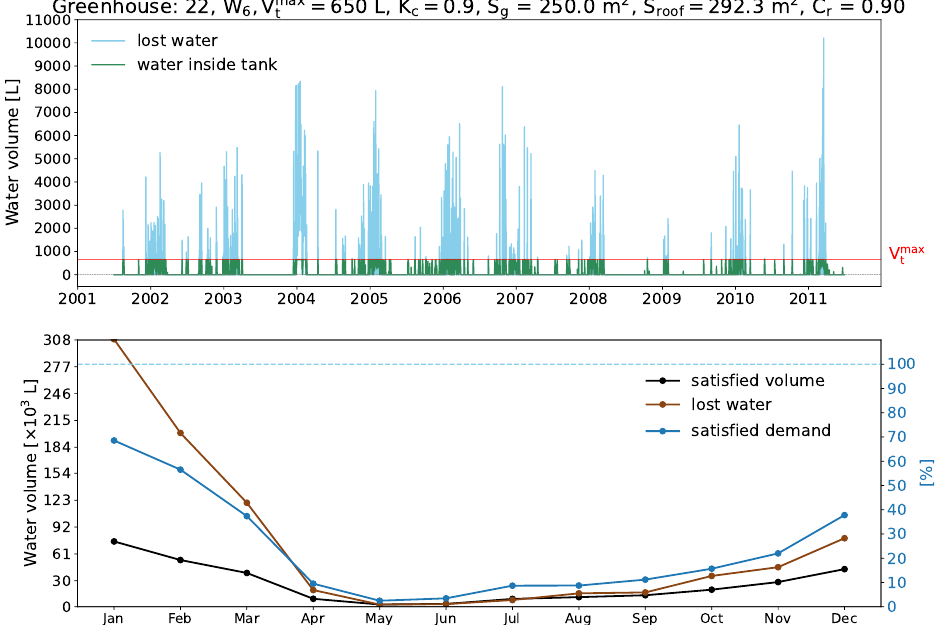
Figure 6. Example of a Type 2 simulation performed with Equation (3) for greenhouse 22 (see the main characteristics in Table 2). The simulation is performed for the next set of parameters: S roof = 292.3 m 2 , C r = 0.9, W i = W 6 (second window of Copancara station, Table 2), k c = 0.9, = 650 L. ( top panel ) Daily simulation of water inside tank (green) and lost water S g = 250 m 2 , V max t (sky blue). Note that the amount of water inside the tank is V max as maximum. ( bottom panel ) The t 10-year monthly mean computed from daily data. The percentage of satisfied demand (sky blue) has been calculated taking into account the volume of water provided by the tank (black) with respect to the total required, while the water loss (brown) indicates the amount of water does not captured, most likely due to limitations in the storage capacity of the tank. Units of the left y -axis are 10 3